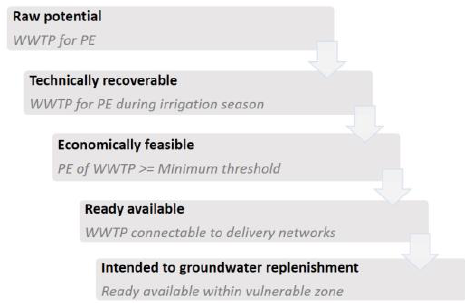
Figure 1. Methodological steps.